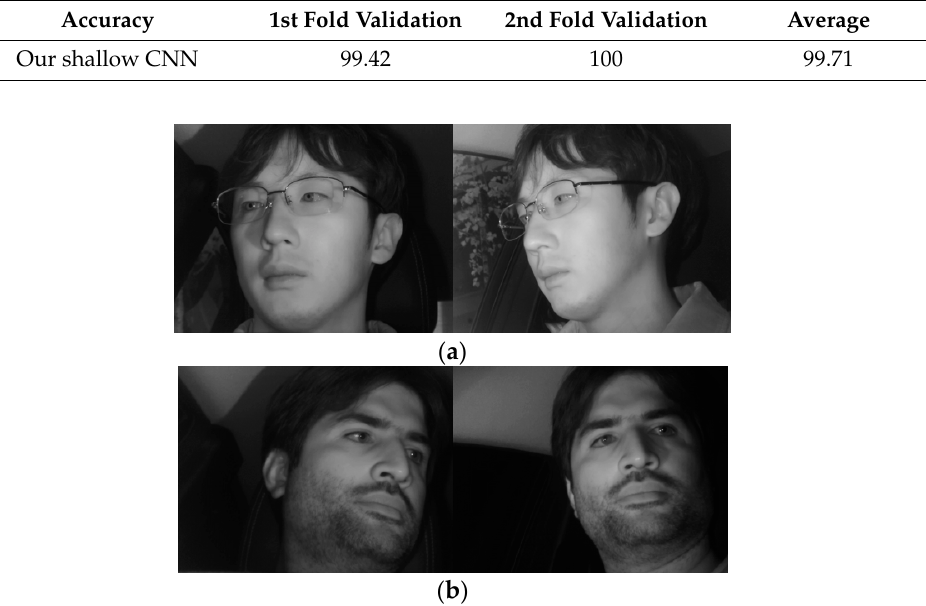
Figure 14. Examples of correct classification cases of frontal face image. ( a ) Left image selected; ( b ) Right image selected.